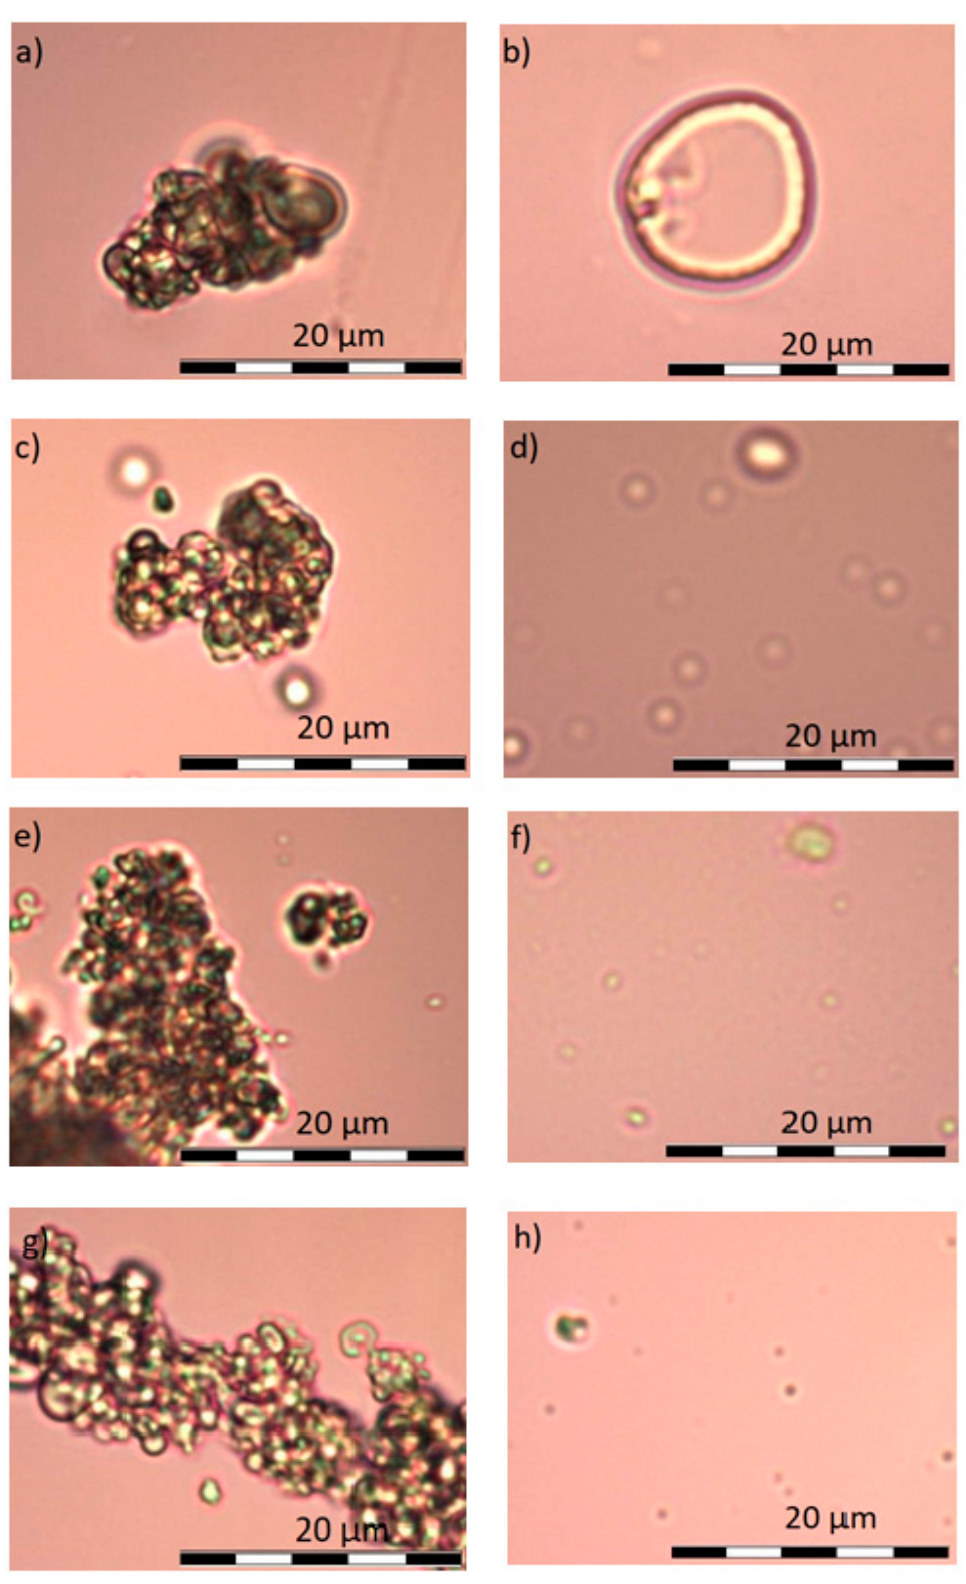
Figure 6. ( a ) liposomes H in zoom 200 × ( b ) liposomes H after mixing and in zoom 400 × ( c ) liposomes I in zoom 200 × ( d ) liposomes I after mixing and in zoom 400 × ( e ) liposomes J in zoom 200 × ( f ) liposomes J after mixing and in zoom 400 × ( g ) liposomes K in zoom 400 × ( h ) liposomes K after mixing and in zoom 400 ×.